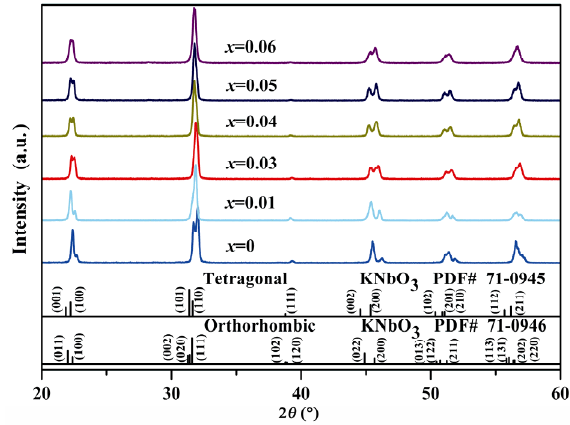
Fig. 2 XRD patterns for KNN– x BLZ ceramics sintered at 1110 ℃